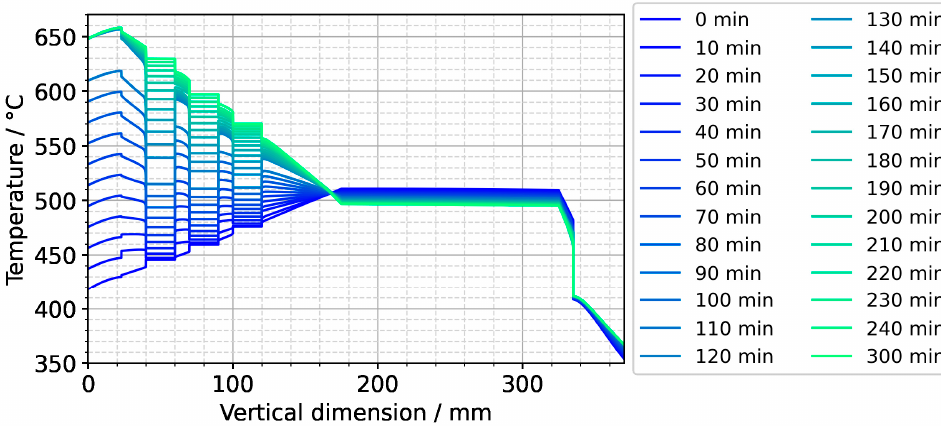
Figure A2. Quasi-stable dissolution stage conditions for the model version with slim seeds: Tem- perature field with streamlines visualizing fluid flow directions (left) and velocity magnitude field (right).